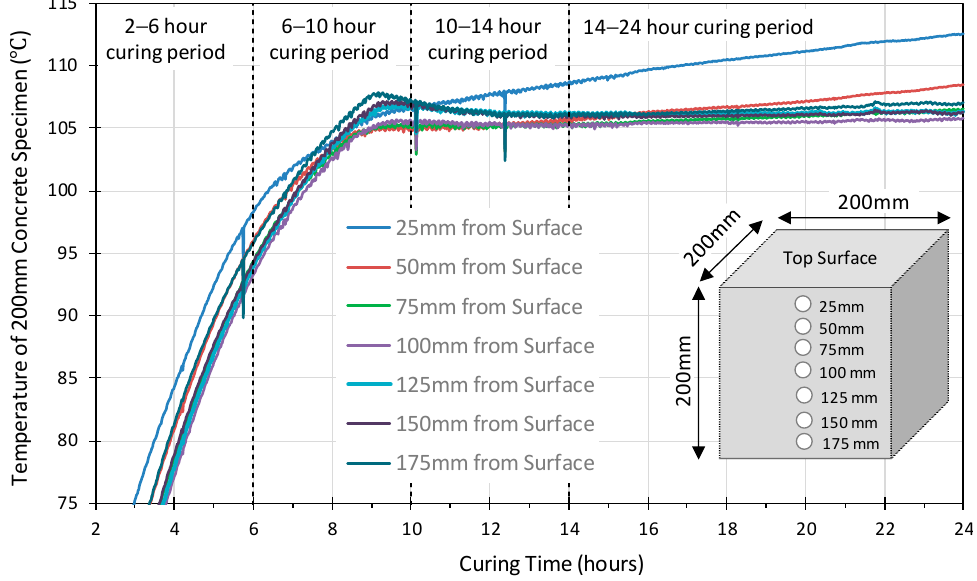
Figure 3. The temperature development versus the depth of 100 mm geopolymer concrete cube.